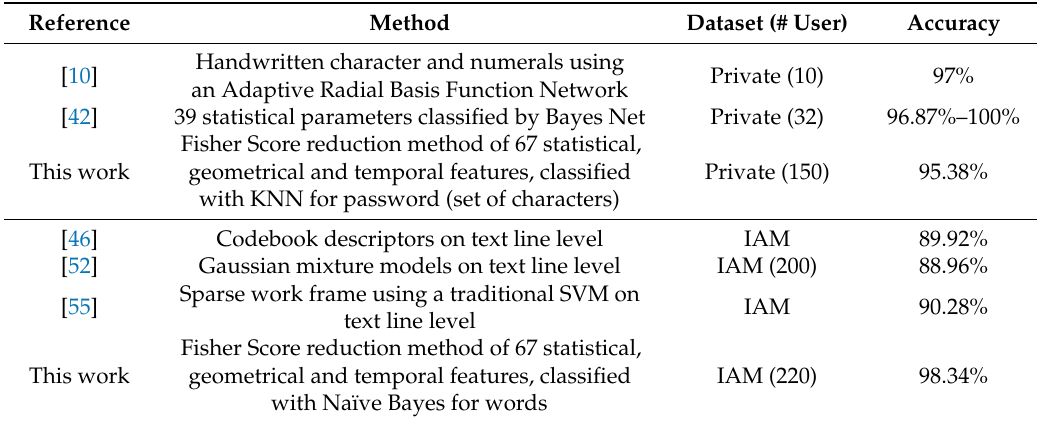
Table 18. Comparison between the actual work and the